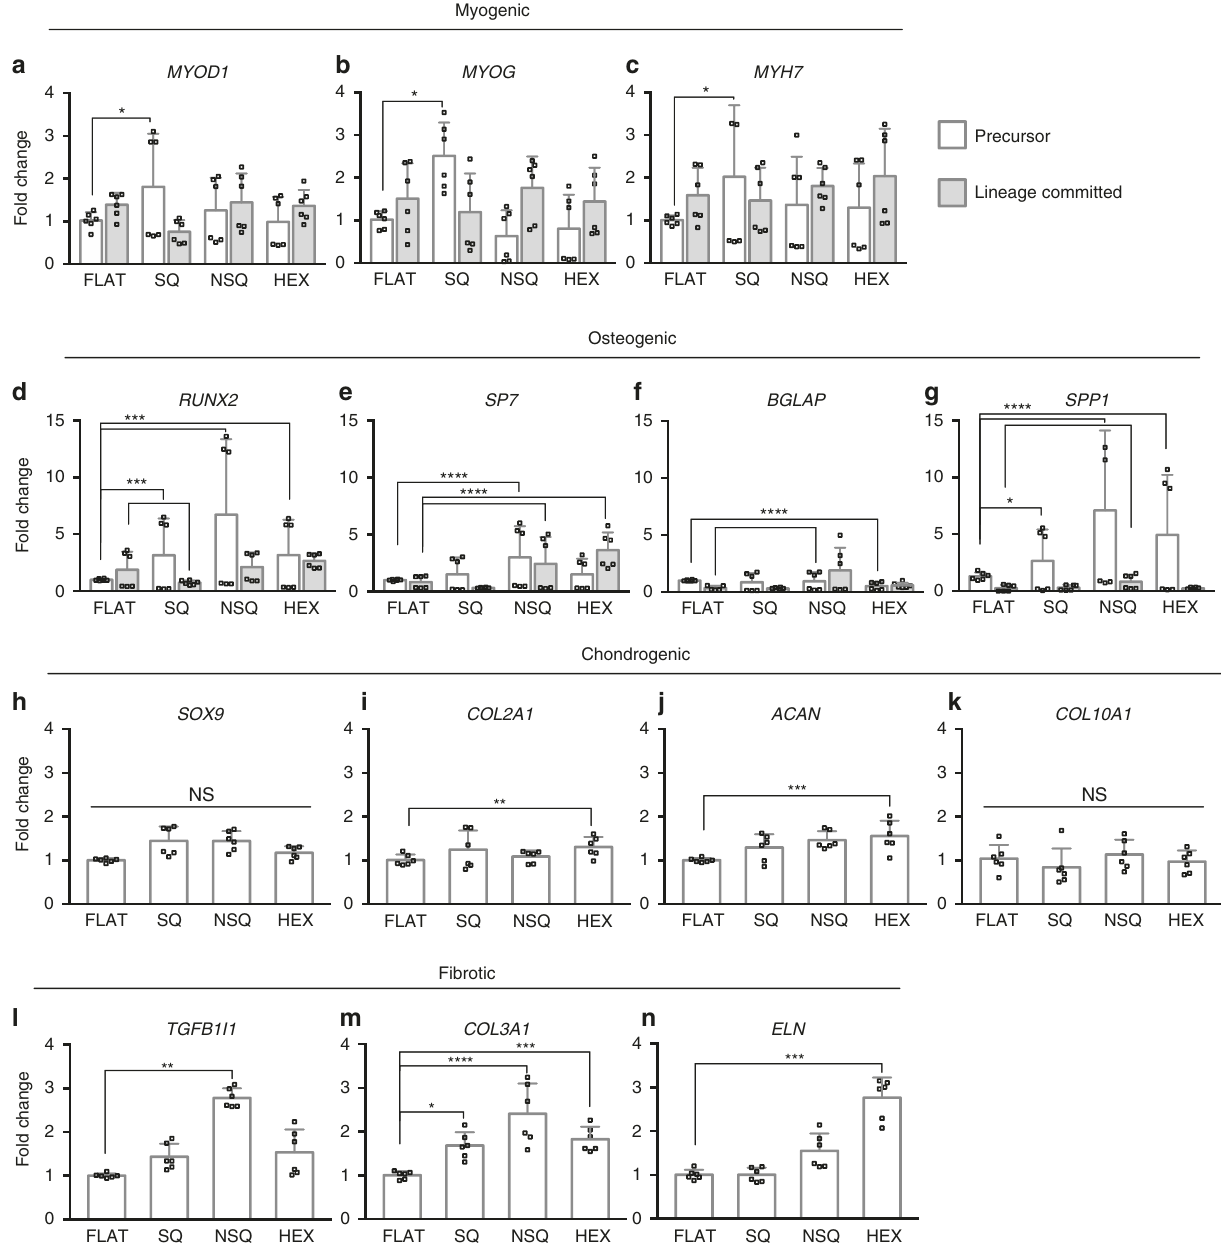
Fig. 3 Gene expression is changed by nanotopography. Changes in musculoskeletal gene expression from musculoskeletal cell types in response to nanotopographies. Measurement of a – c myogenic markers from pre-myoblasts and myoblasts, d – g osteogenic markers from pre-osteoblasts and osteoblasts, h – k chondrogenic markers from chondrocytes, l – n fi brotic markers from fi broblasts on nanotopographies. See Supplementary Data 2 for the complete gene expression data. Precursor (pre-myoblast and pre-osteoblast) and lineage committed (myoblast and osteoblast) cells were from the same cell line, but with lineage committed cells cultured in the presence of inducers of osteogenic or myogenic differentiation. Gene expression is listed in order of increasing maturity for the given cell lineage. QPCR measurements shown here were normalized to the reference gene and cell type on FLAT. All QPCR measurements are given as mean ± standard deviation from two independent experiments ( n = 6). Open faced squares denote individual QPCR measurements. Signi fi cance levels obtained from one-way ANOVA with Tukey ’ s post-hoc test for pairwise comparison. Signi fi cance levels were denoted by *( p < 0.05), **( p < 0.01), ***( p < 0.001), and ****( p < 0.0001). signi fi cantly across cell types (Fig. 4, see Supplementary Data 3). decrease and positive values denoting increase from the mean = 0. For ease of visualization of a multivariate dataset, hierarchical When taken entirely, hierarchical clustering of the morphome clustering was employed to group morphome features of high revealed distinct morphological pro fi les of all combinations of cell similarity together and thus reveal morphological pro fi les across type and nanotopography (see Supplementary Fig. 7). Our results different nanotopographies. Before clustering, each morphome were further distilled to hierarchical clustering of the morphome feature was mean centered and normalized, transforming each separated by cell type (Fig. 4 and Supplementary Data 4). When morphome feature to a relative scale with negative values denoting compared to FLAT, pre-myoblasts on SQ showed high average NATURE COMMUNICATIONS| (2020) 11:1384